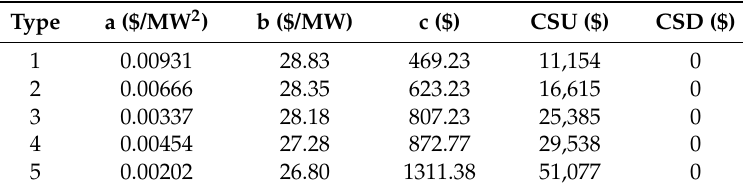
Table 2. Economic parameters of the units.